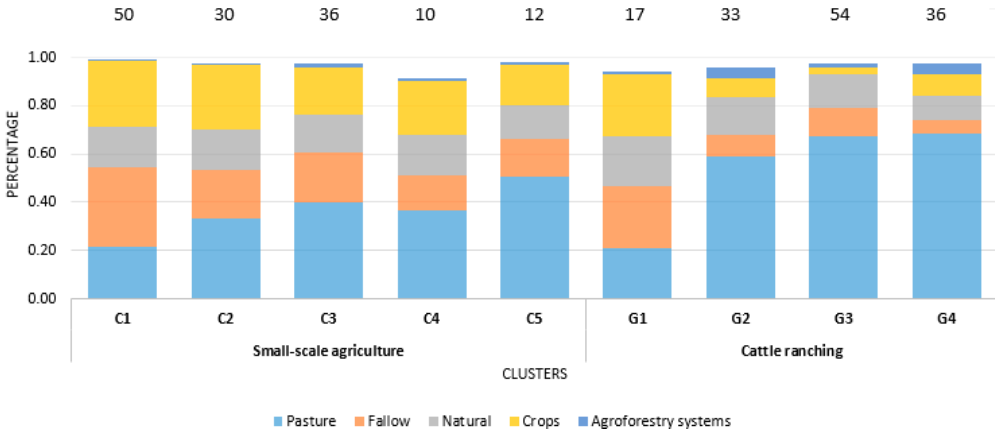
Figure 6. Land-uses by the different groups of farms. Small-scale family agriculture was characterized by more diversified land-use, while in cattle ranching, pastures are predominant. Above are the numbers of farms per cluster.